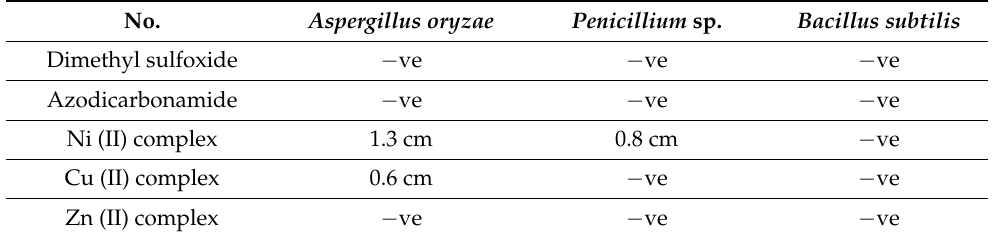
Table 5. The inhibition diameter (cm) of azodicarbonamide ligand and its metal complexes. No. Aspergillus oryzae Penicillium